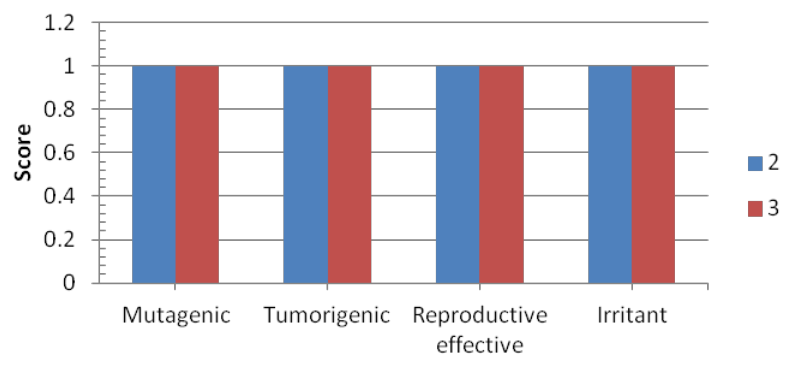
Figure 7. In silico drug safety analysis for thienyl derivatives by Osiris software.